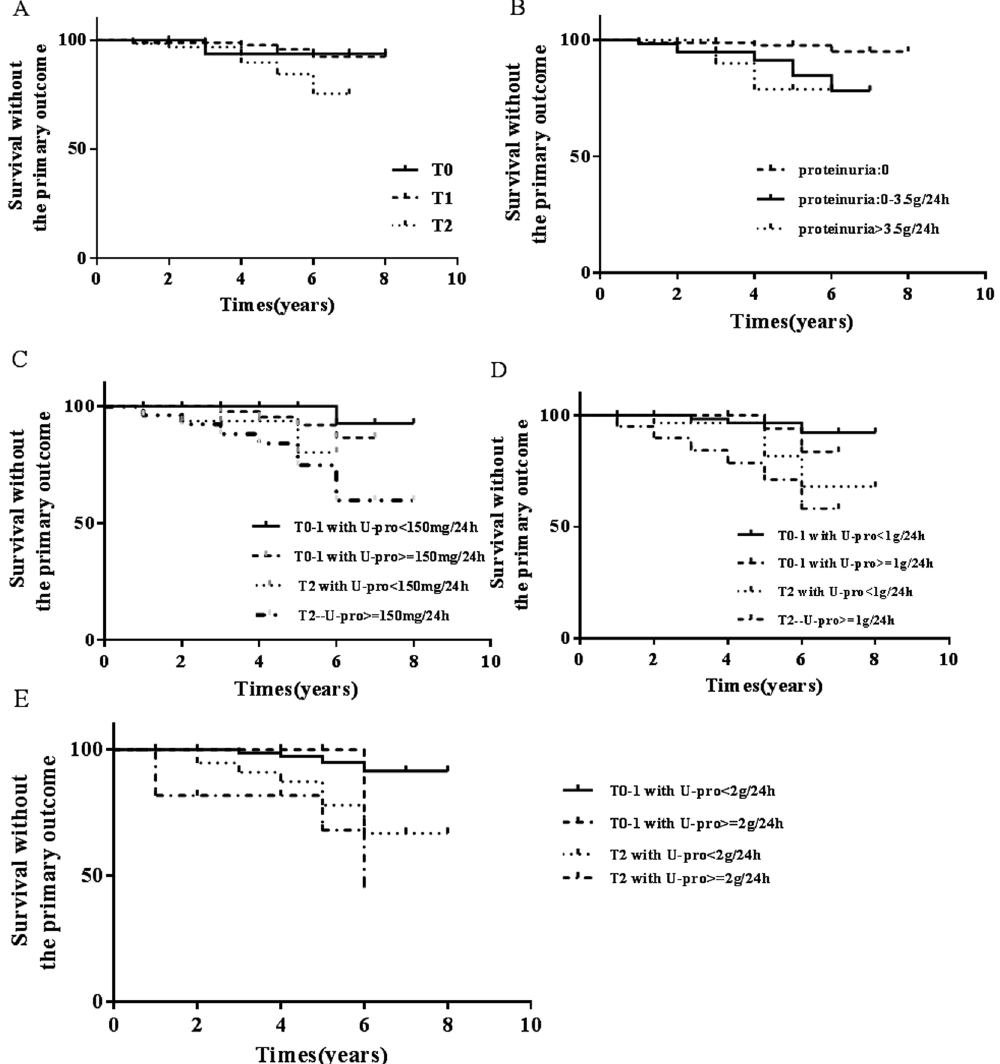
Figure 1. The risk of the primary renal outcome (50% reduction in estimated eGFR or endstage renal disease) according to T scores and proteinuria. Kaplan–Meier survival curves stratified according to the scores for tubular atrophy/interstitial fibrosis ( A ), proteinuria levels at the time of biopsy ( B ), different T scores combinded with/without proteinuria at biopsy ( C ), different T scores combinded with proteinuria levels ≥ or < 1.0 g/24 h ( D ), and different T scores combinded with proteinuria levels ≥ or < 2.0 g/24 h ( E